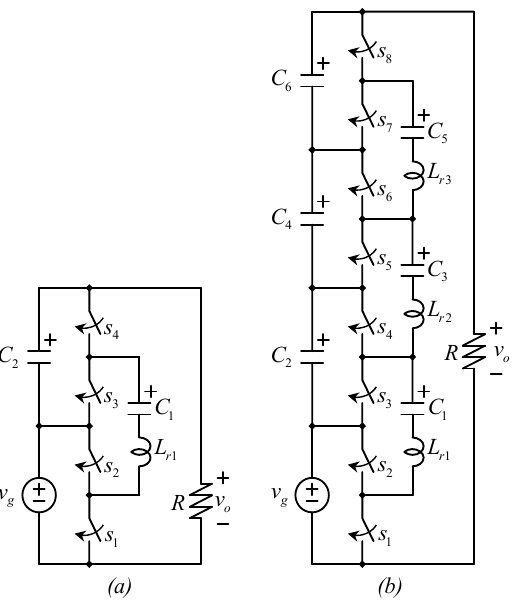
Figure 28. The resonant ladder SC converter, ( a ) 2× version, ( b ) 4× version. This converter has been used in several applications, mainly for voltage equalization in a series of capacitors or batteries [102–106]. The resonant charge interchange can be produced in a traditional SC converter by introducing small inductors in some parts of the circuit. The multilevel boost converter, see Figure 26, or multiplier boost converter has also been studied in their resonant charge interchange version [41], see Figure 29.